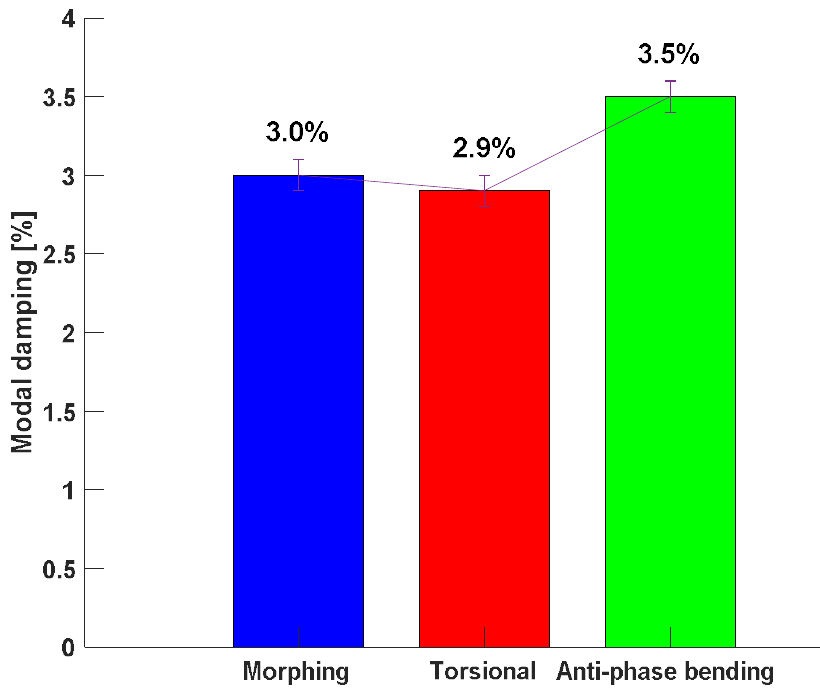
Figure 24. Damping ratio for each modal deformation.